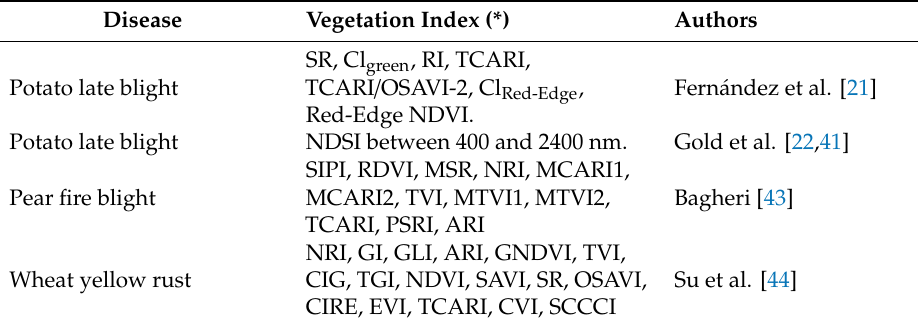
Table 9. Literature comparison of spectral variables tested for detect crop diseases. Disease Vegetation Index